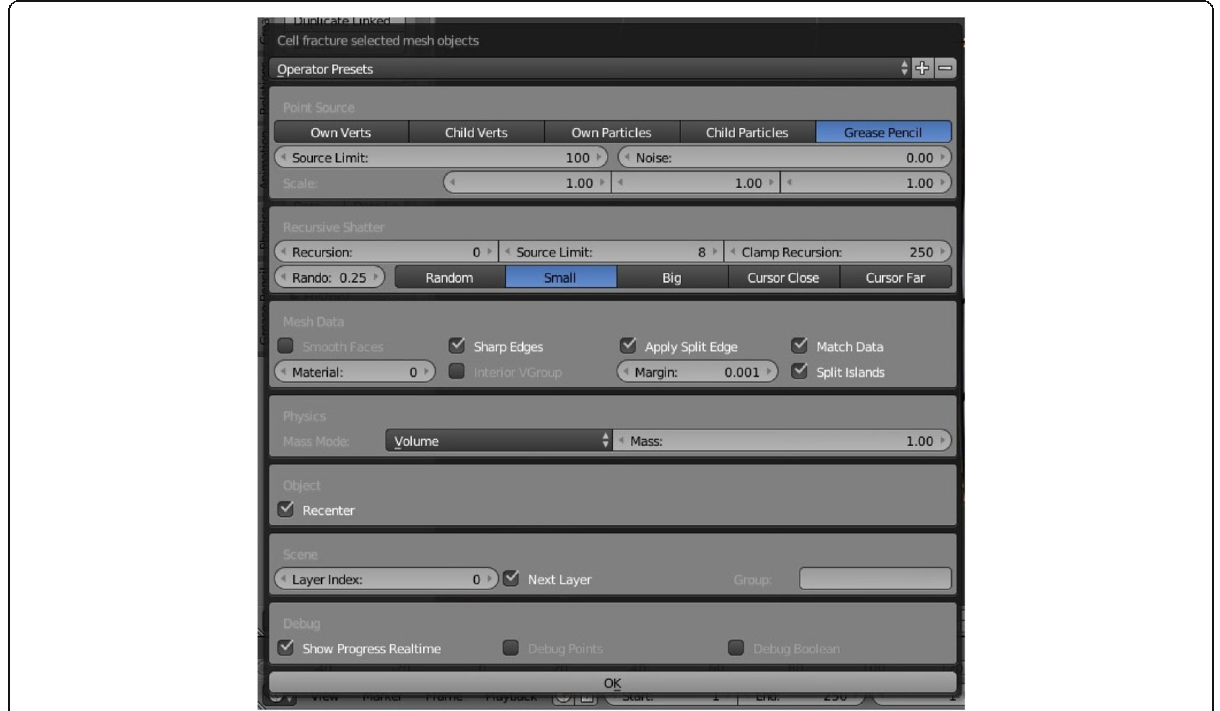
Fig. 11 Implementation of Cell Fracture plug-in in Blender software